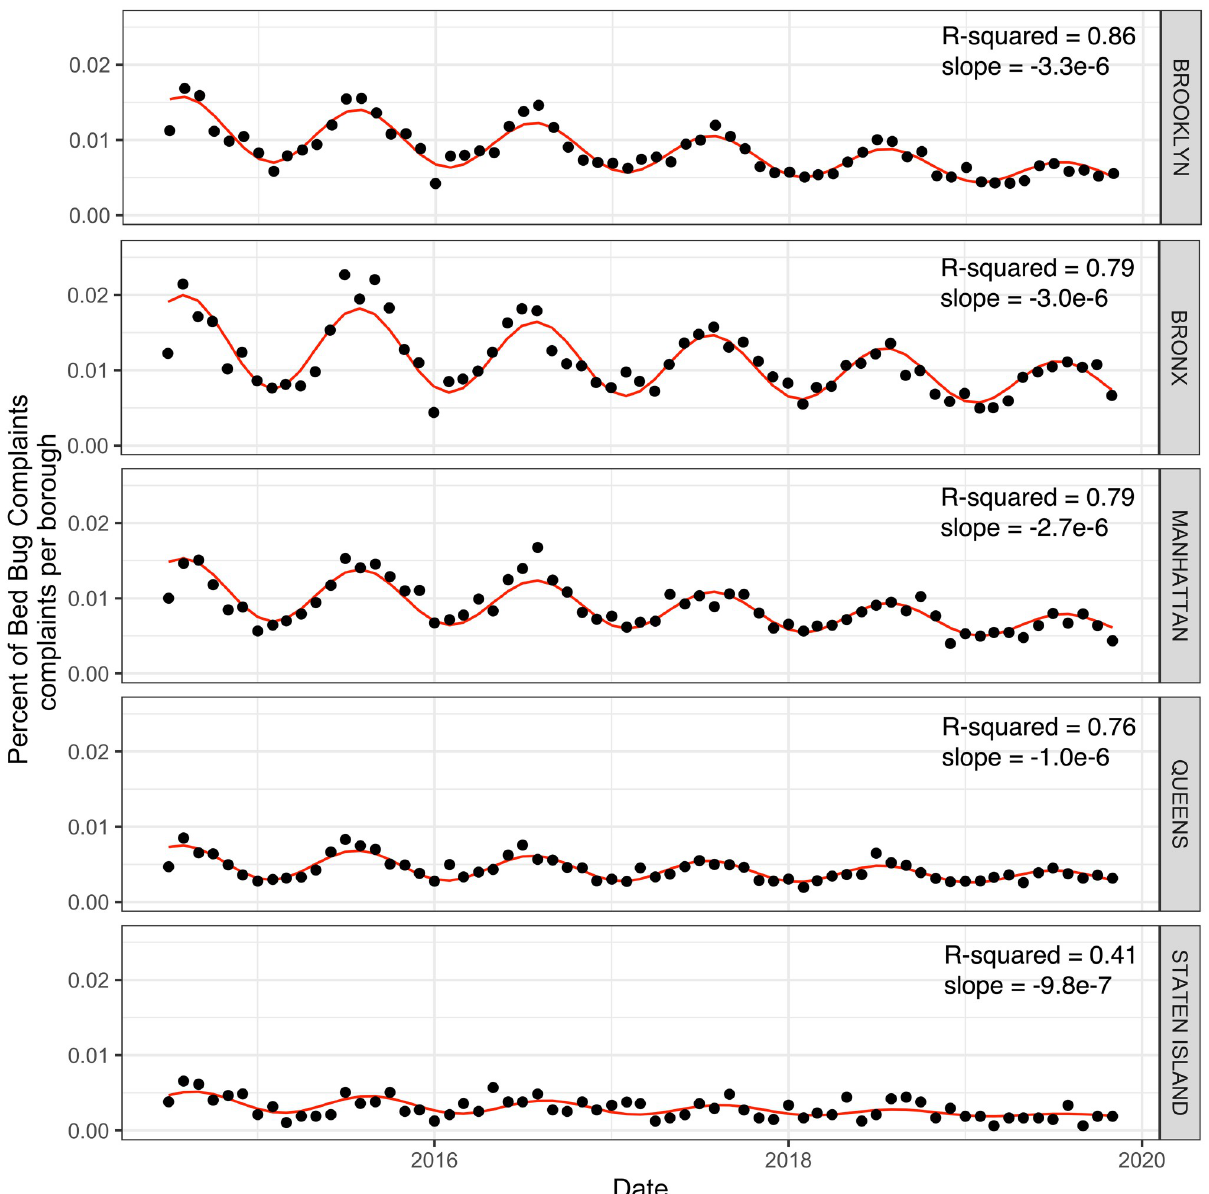
Fig 3. Harmonic linear model assessing the temporal patterns of official bed bug complaints for each of the five NYC boroughs. Graphical representation of model results assessing official bed bug complaints per each of the NYC borough standardized by borough population from 2014– 2019. Model fit assessed by R-squared, and slope of the linear residual pattern are